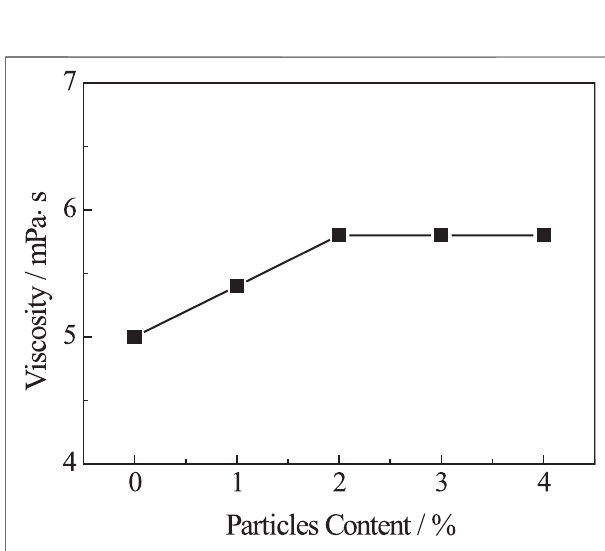
FIGURE 4 | Effect of PTFE particle concentration on apparent